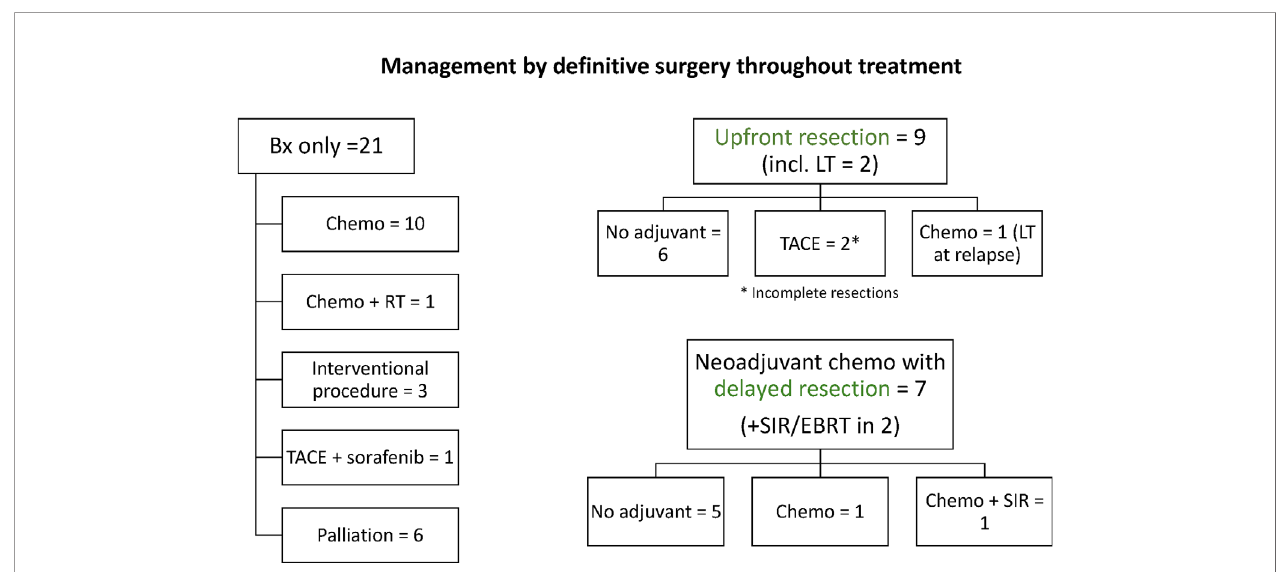
FIGURE 2 | Summary of neoadjuvant and adjuvant treatment regimens received by patients in our cohort according to resectability (two patients with missing or incomplete treatment details